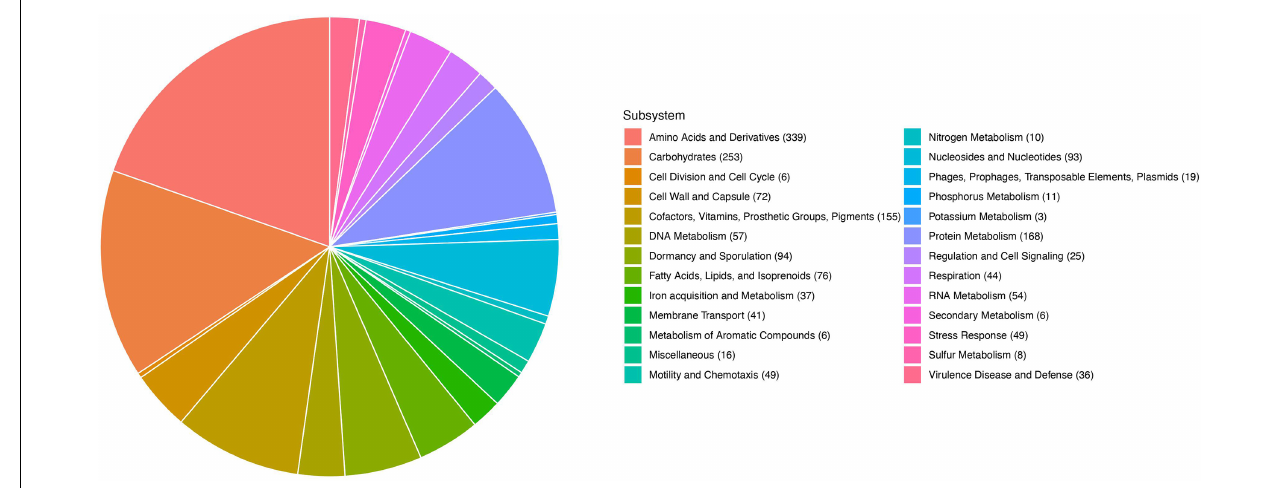
FIGURE 2 | RAST annotation of the 2845 predicted genes in the C3 genome. Allocation of gene categories in the whole genome sequence of